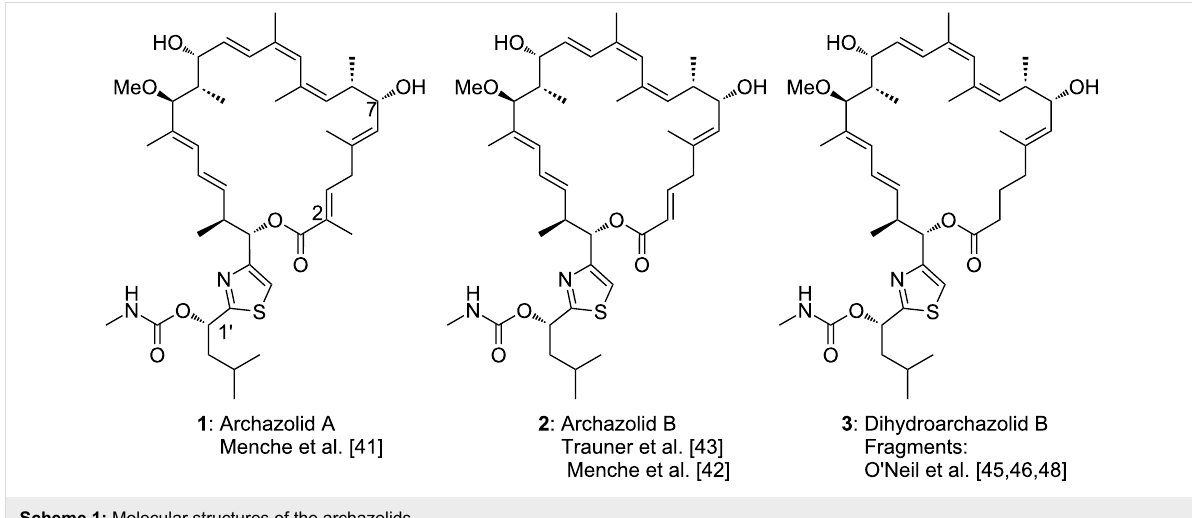
Scheme 1: Molecular structures of the